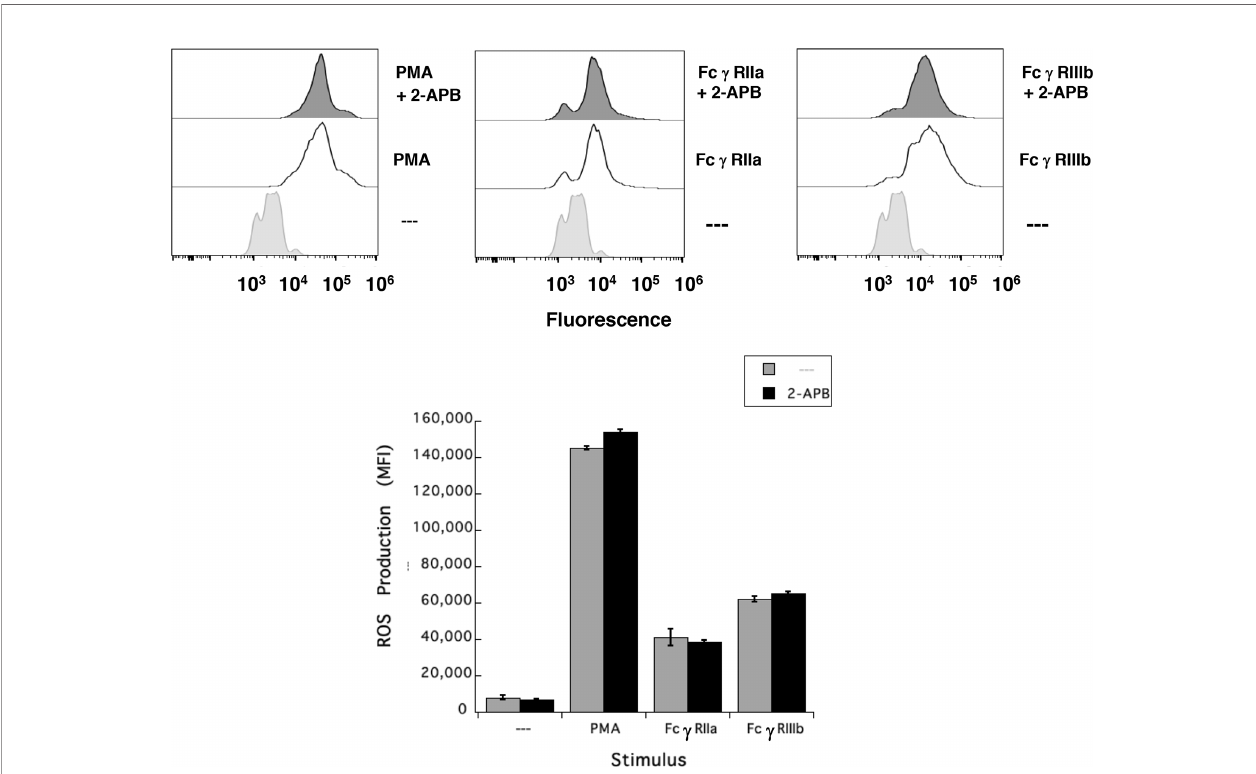
FIGURE 6 | TRPM2 is not required for Fc g RIIIb-induced ROS production. Reactive Oxygen Species (ROS) production was assessed in dihydrorhodamine 123- loaded neutrophils by detecting fl uoresce changes by fl ow cytometry. Neutrophils were previously left untreated ( — ), or were treated with the 5 µM 2-APB, a TRPM2 inhibitor, before being stimulated with 20 nM PMA, or by aggregating Fc g RIIa, or by aggregating Fc g RIIIb. Data are mean ± SEM of mean fl uorescence intensity (MFI) from three independent experiments done in